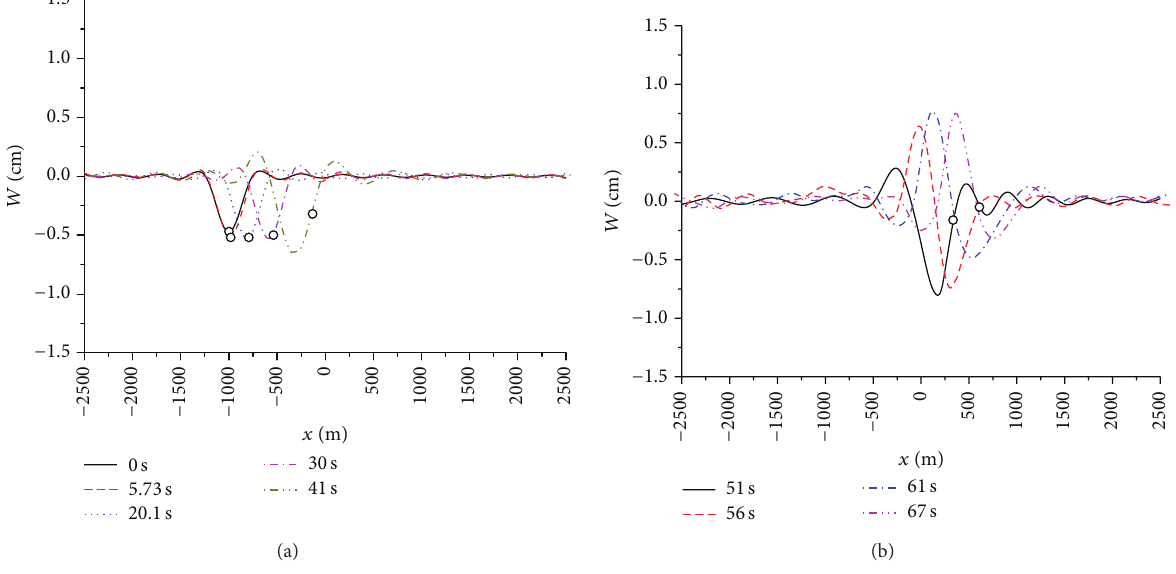
Figure 15: Spatial profiles of the runway subjected to takeoff run.